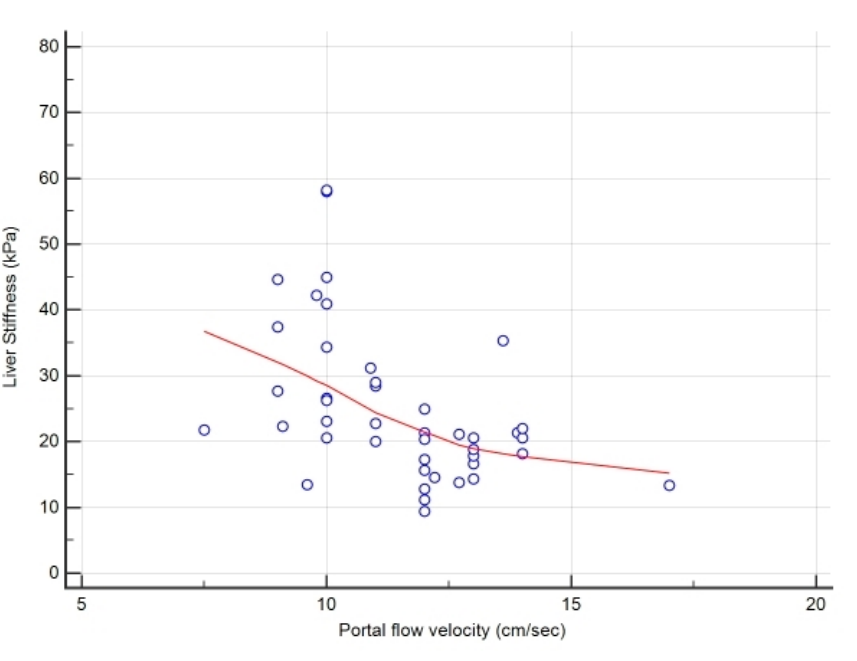
Figure 3. Correlation graphic between LS and portal flow velocity for the FALD staging.